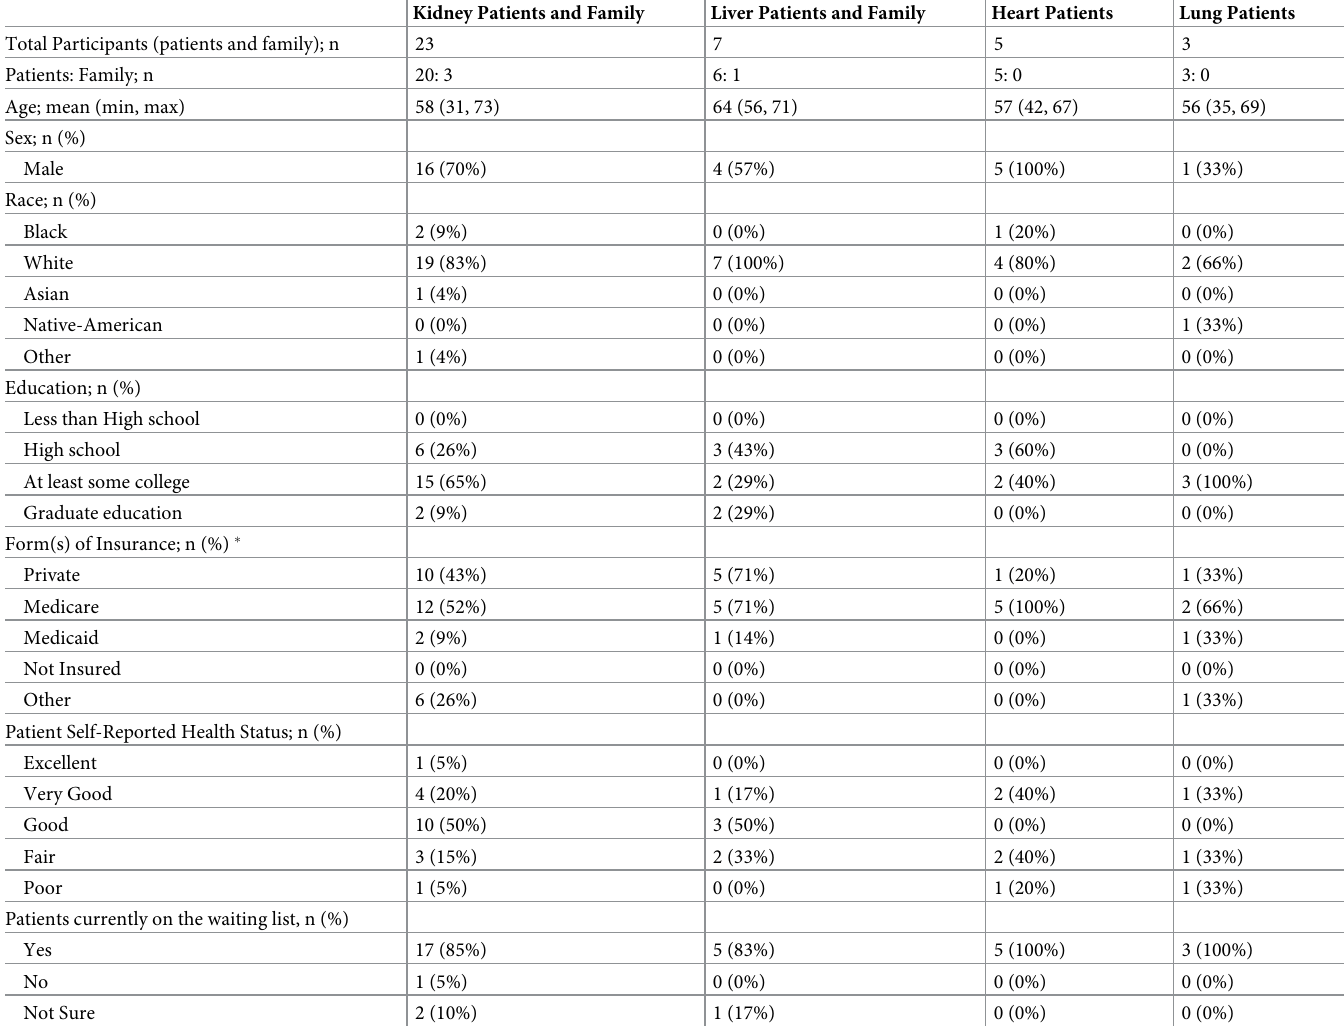
Table 3. Characteristics of transplant patients and family who participated in usability